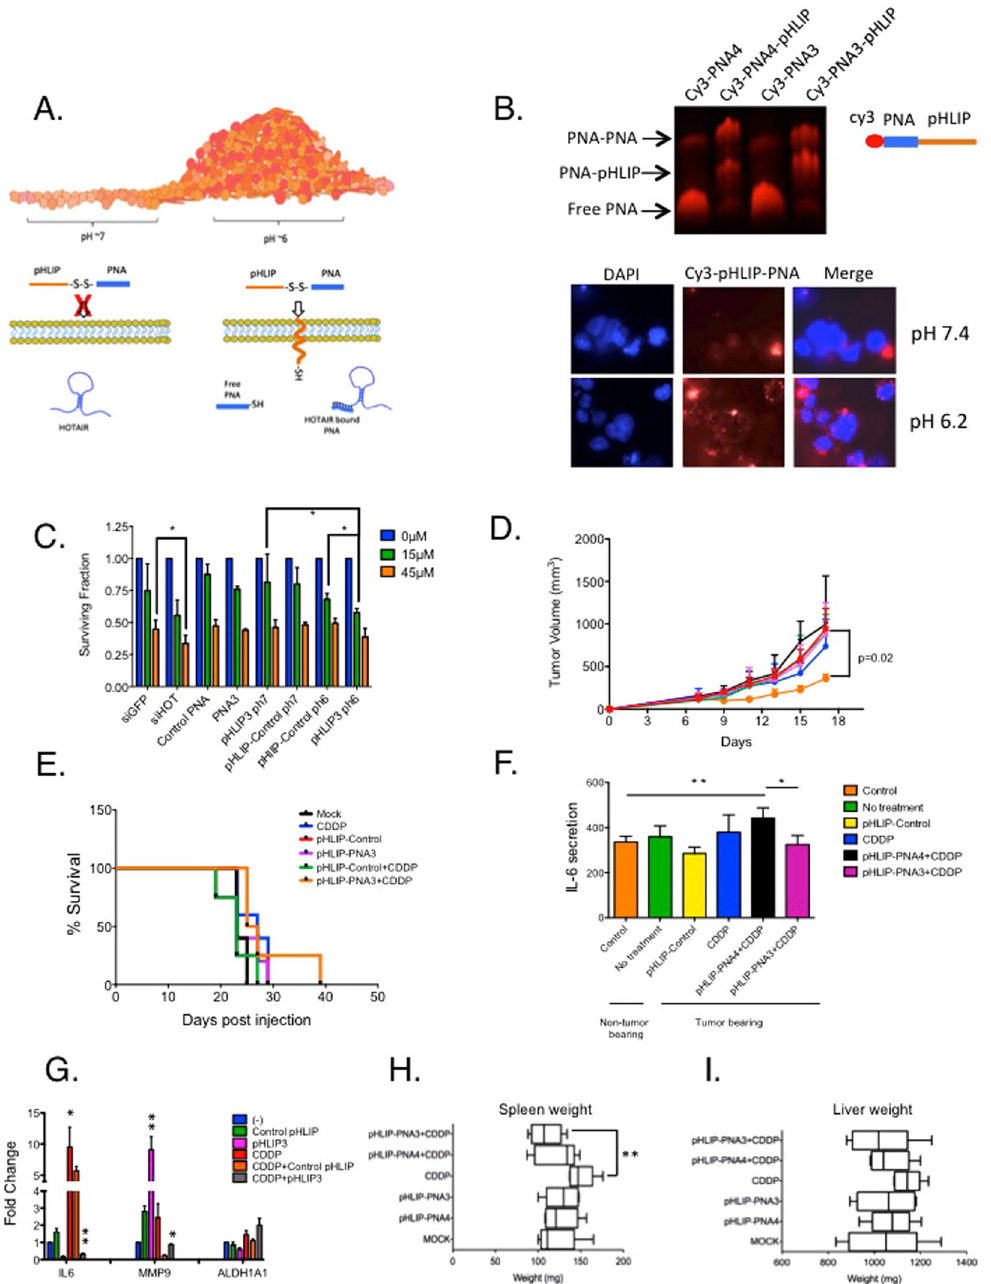
Figure 4. pHLIP-PNA peptide is pH specific and can resensitize ovarian cancer cells to cisplatin in vivo and increases survival. ( A ) Diagram illustrating the mechanism for pHLIP-PNA mediated targeting of lncRNA HOTAIR. ( B ) pHLIP-peptide conjugation to cy3 labeled PNA in a 4% TBE-acrylamide gel and immunofluorescence showing pHLIP-PNA entering cells in low and high pH conditions (pH 6.2 vs pH 7.4). ( C ) A2780_CR5 treated with pHLIP-PNA3 or pHLIP-PNA-Control (1 μ M) for 1 hr followed by a 3 hr treatment with indicated concentrations of CDDP (0, 15, 45 μ M). Survival was measured with MTT (72 hrs post treatment). ( D ) Tumor growth in response to PNA or cisplatin (CDDP) treatment; arrows represent 1 mg kg − 1 PNA and/or 2 mg kg-1 CDDP n = 5. ( E ) Survival in response to anti-lncRNA treatment. Cutoff criteria included tumor volume greater than 1 cm 3 or protocol-mandated euthanasia; n = 5 for all groups. ( F ) Blood IL-6 levels at the last biweekly collection; n = 5 for all groups. ( G ) Gene expression analysis as measured by qRT-PCR for HOTAIR target genes: IL-6, MMP-9, and ALDH1A1. ( H ) Average spleen weight for all groups of mice collected at the time of euthanasia; n = 5 mice per group. ( I ) Average liver weight for all groups of mice collected at the time of euthanasia; n = 5 mice per group. Asterisks indicate P < 0.05 ( * ) or P < 0.01 ( **